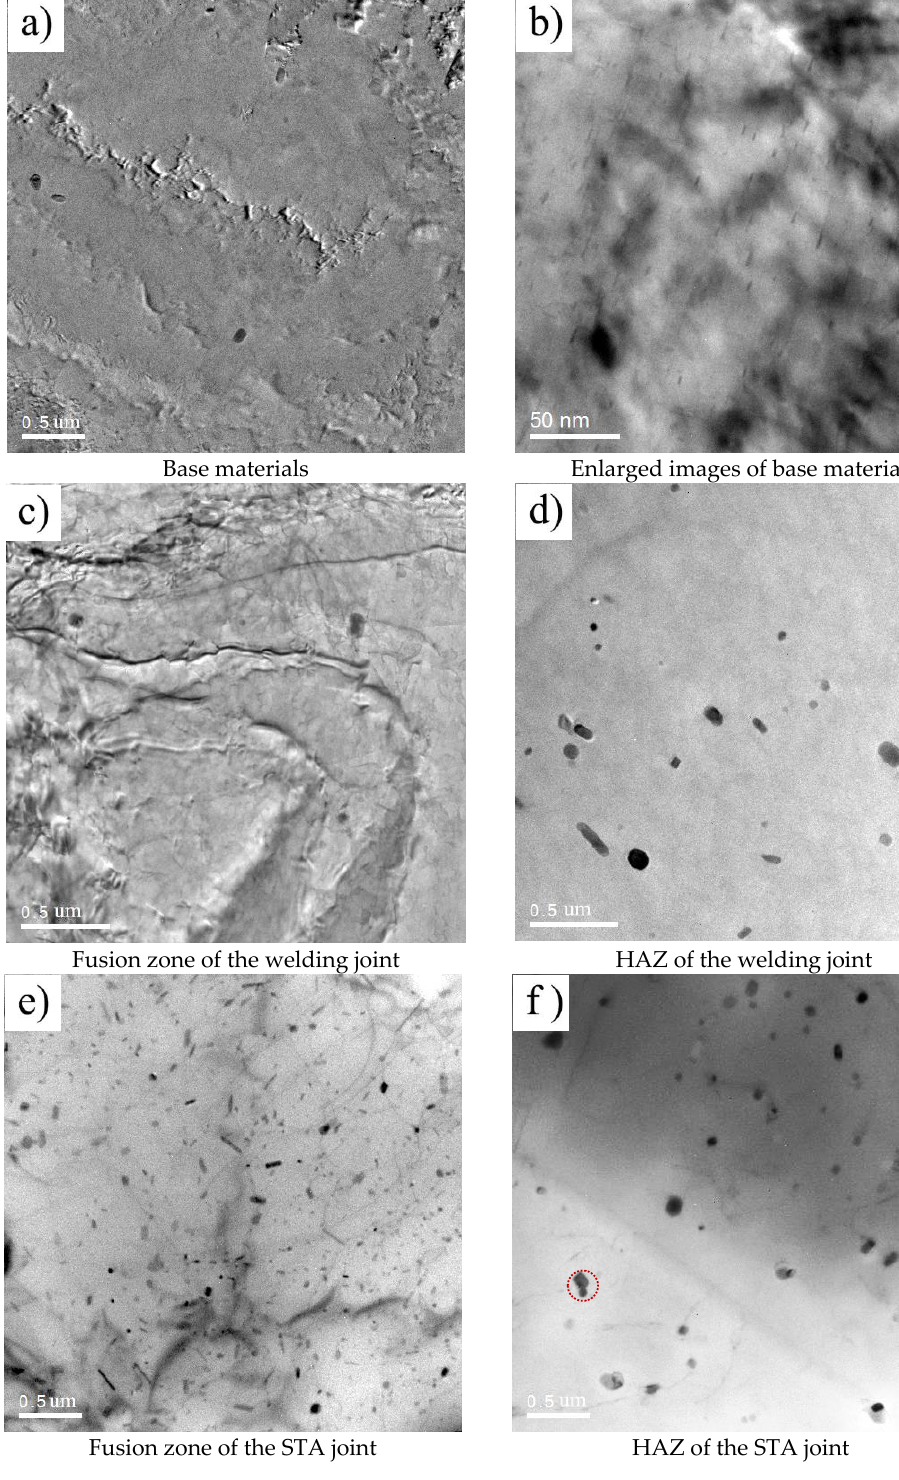
Figure 9. Distribution of β″ and in β in 6061-T6 BM and hybrid welded joints.